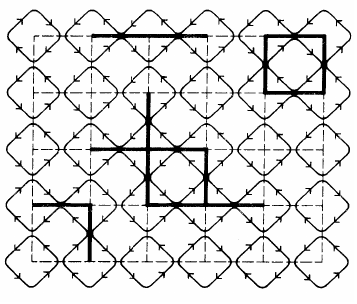
Figure 2: Passing from a cluster configuration to an oriented loop configuration (figure from [ 3 ]